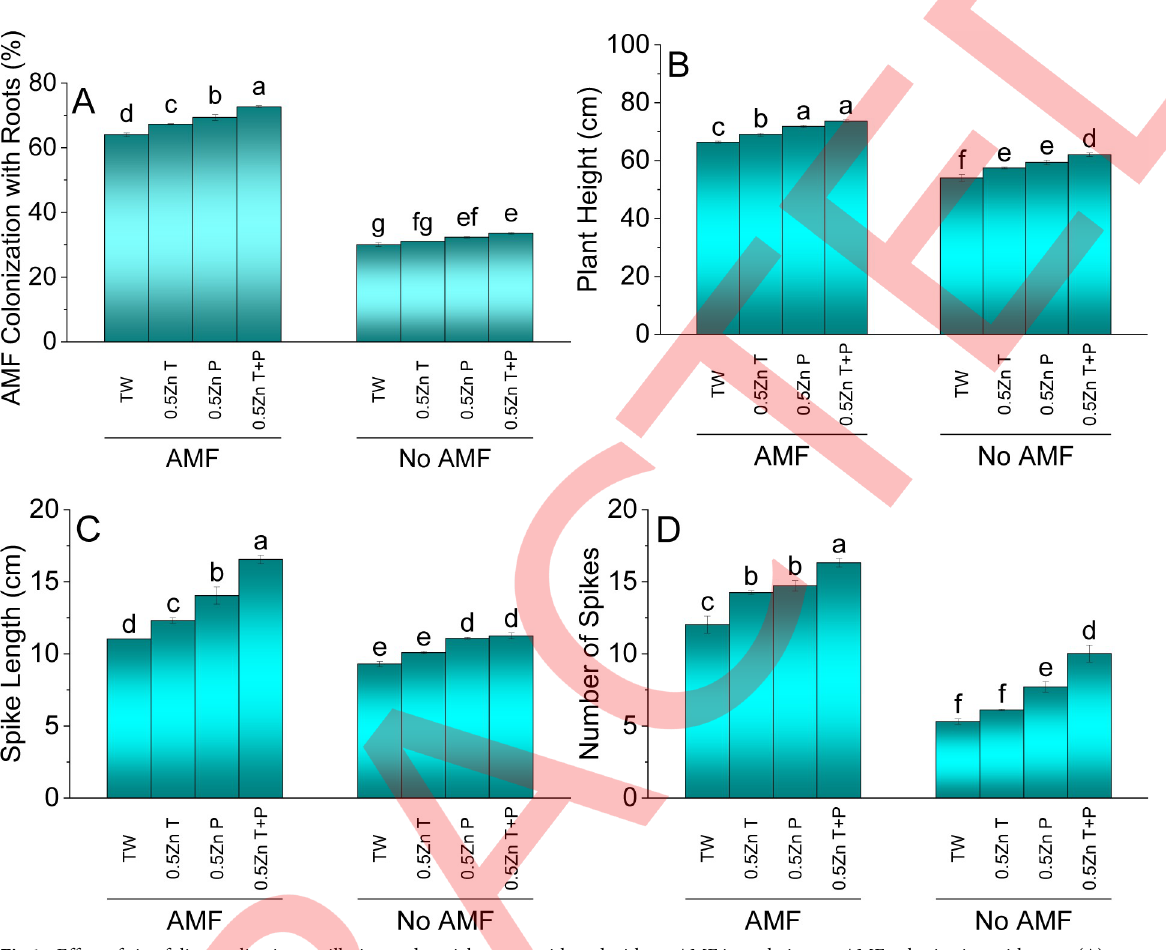
Fig 1. Effect of zinc foliar application at tillering and panicle stages with and without AMF inoculation on AMF colonization with roots (A), plant height (B), spike length (C) and number of spikes (D) of rice. Bars are means of three replicates ± SE. Variable letters on bars indicate significant difference at p � 0.05 according to LSD test. TW = tap water (control); T = tillering stage; P = panicle stage; Zn = zinc.